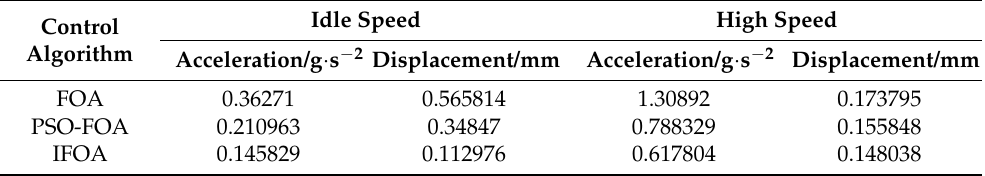
Table 3. RMS of different